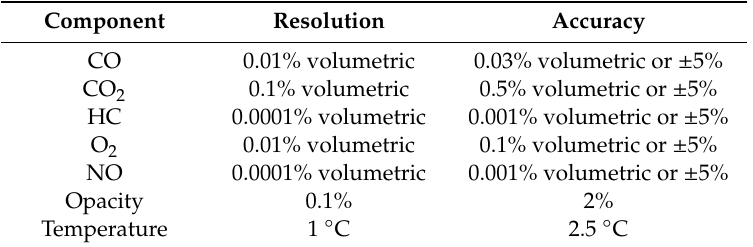
Table 5. Specifications of the emission analyzer and opacimeter BrainBee.